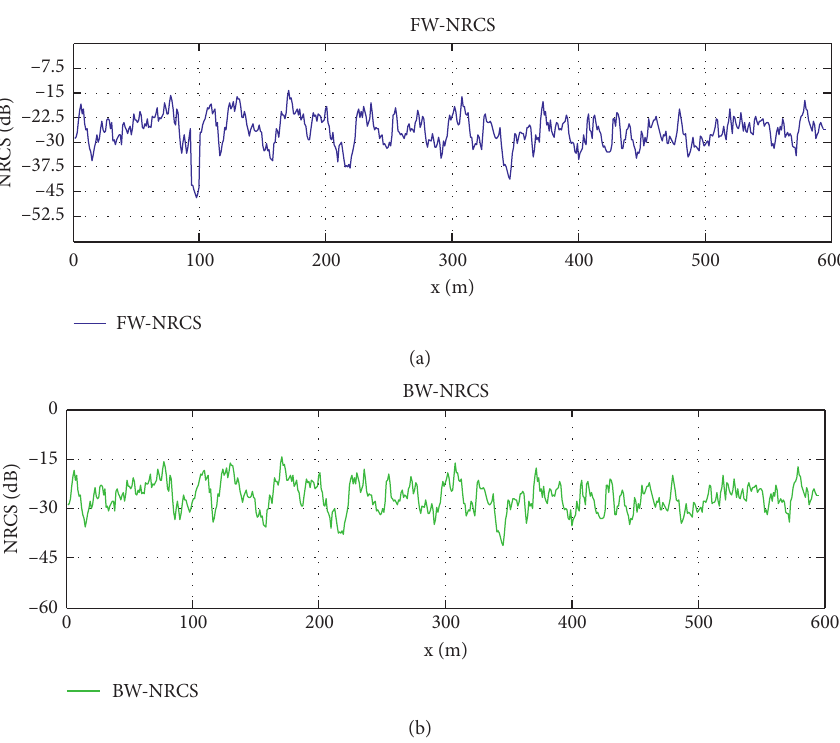
Figure 10: NRCS comparison result of simulated freak waves and their background waves based on